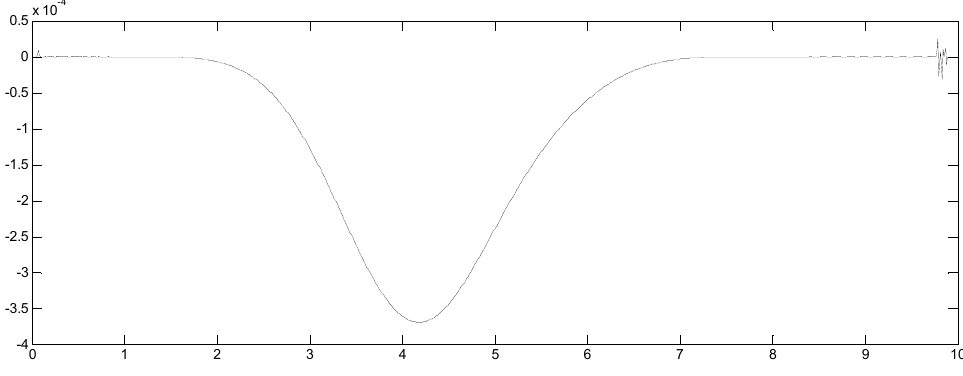
Figure 16. Case 1: Evolution of the control law u 2 .